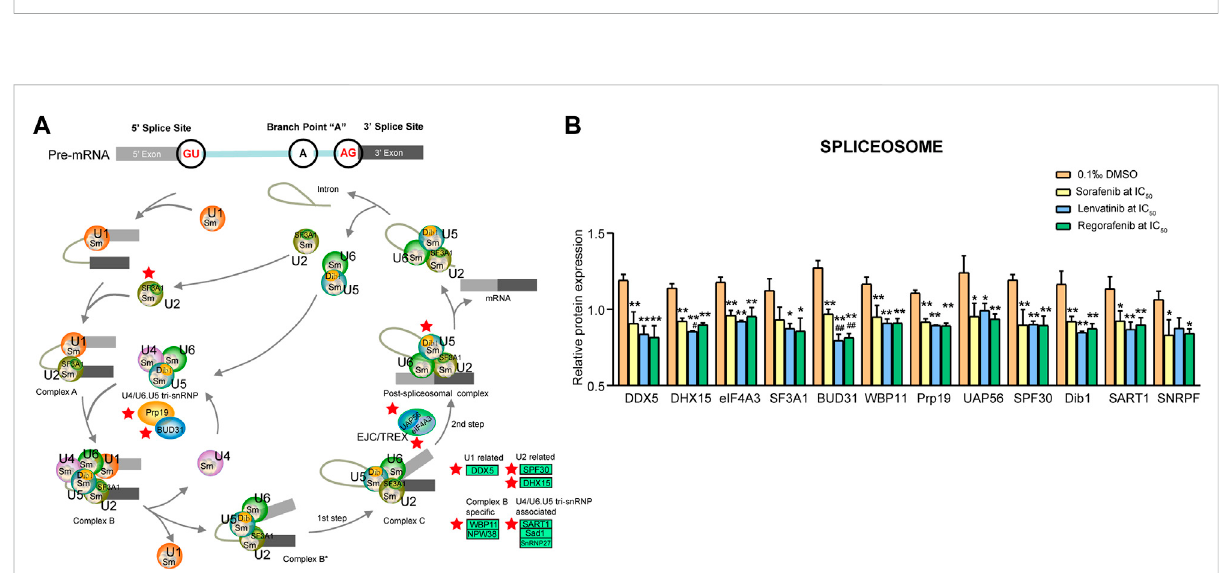
FIGURE 8 Commonly downregulated proteins involved in the spliceosome pathway (A) and their relative expression (B) in Huh-7 cells treated by 72 h incubation with respective sorafenib, lenvatinib and regorafenib. Each bar presents mean ± SD ( n = 3). The * p < 0.05 and ** p < 0.01 versus